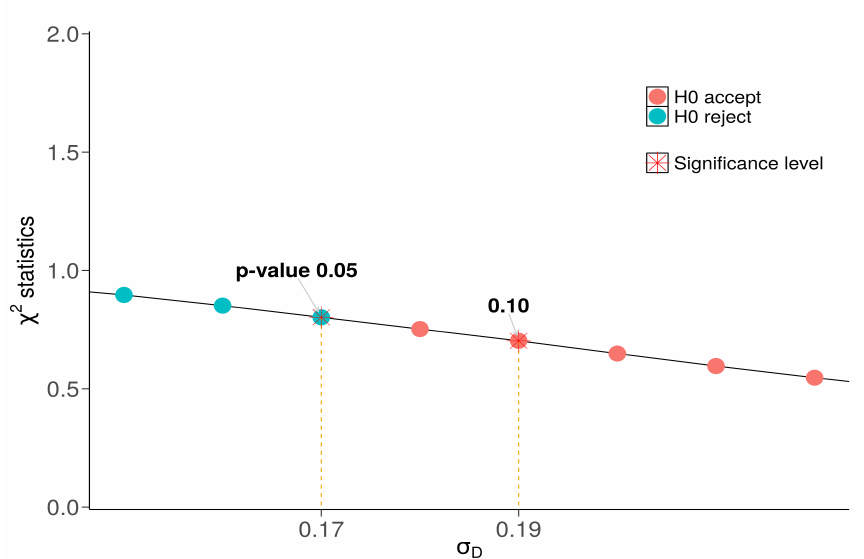
Figure 3. Plot of the chi-square statistic values for the annual maximum daily precipitation (AMP1) as σ D changes. The selected σ D is 0.17 (0.19) for the p -value 0.05